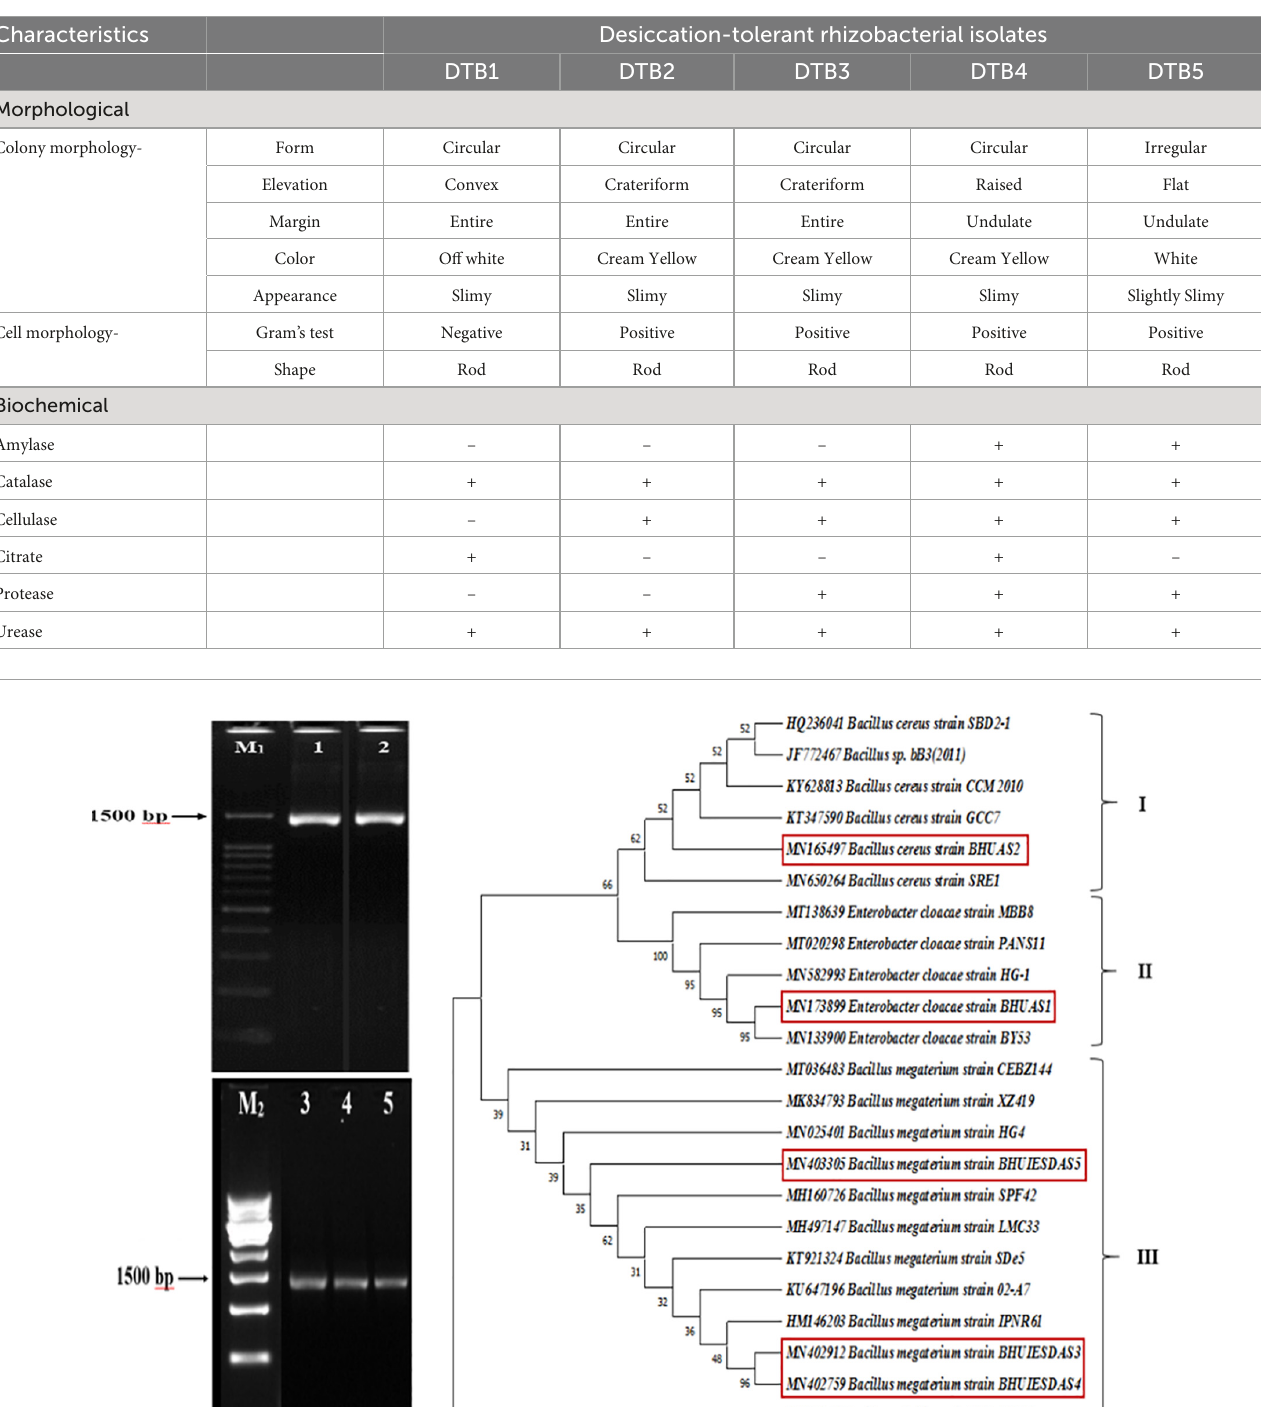
TABLE 1 Morphological and biochemical characteristics of five selected desiccation-tolerant rhizobacterial isolates. Characteristics